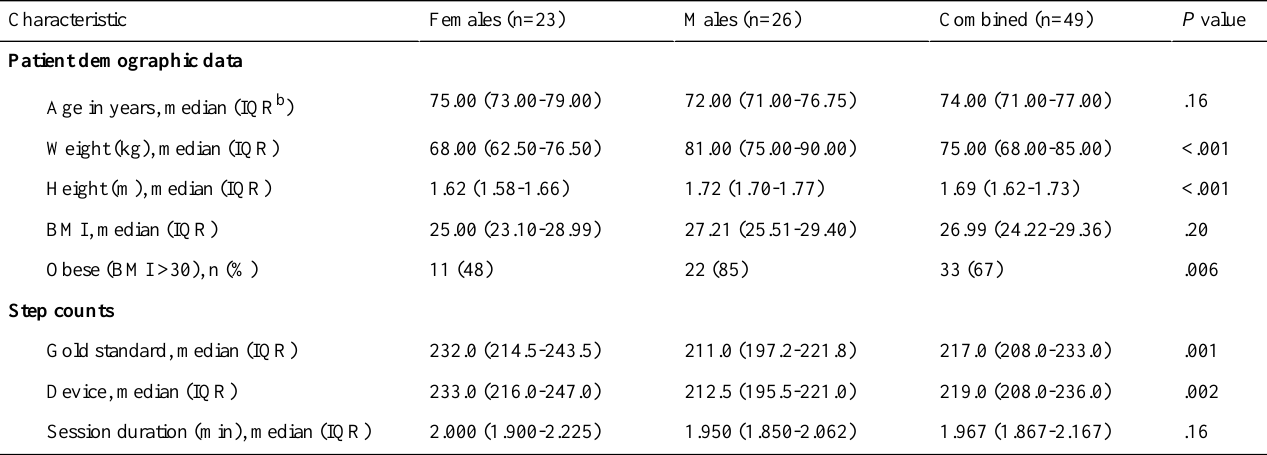
Table 1. Descriptive table of patient characteristics and step counts according to sex a